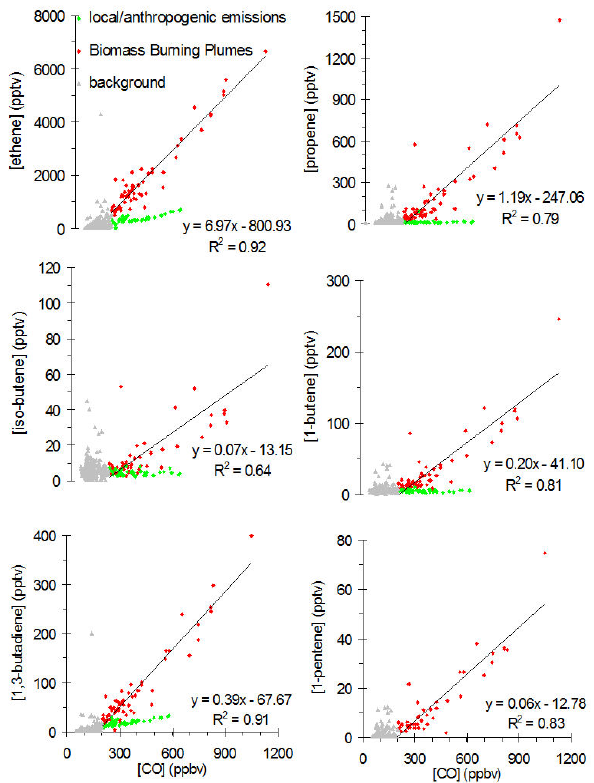
Fig. 2c. Selected plots of aromatics and oxygenates vs. CO. Grey triangles assigned as background air, red diamonds assigned as biomass plumes and green diamonds assigned as anthropogenic